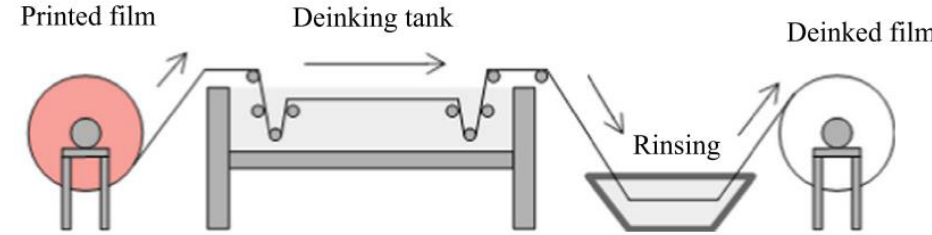
Figure 6. Gamma Meccanica deinking process. Reprinted from publication [3]. Copyright 2018, with the permission from Elsevier. (A color version of this figure can be viewed online). Table 4. Summary of mechanical recycling and deinking process of post-industrial monolayer waste films